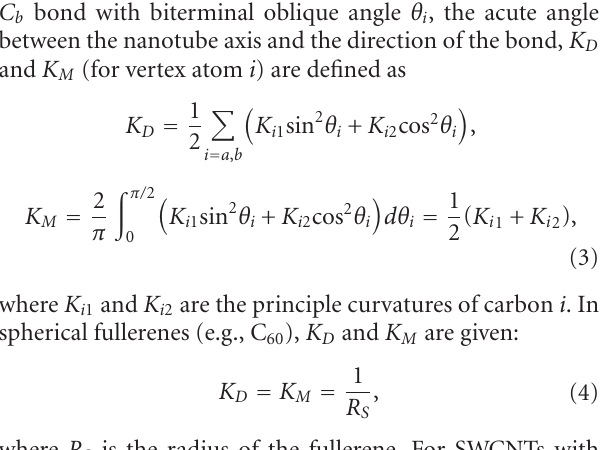
method (Figure 2) [41–43]. In this description, the